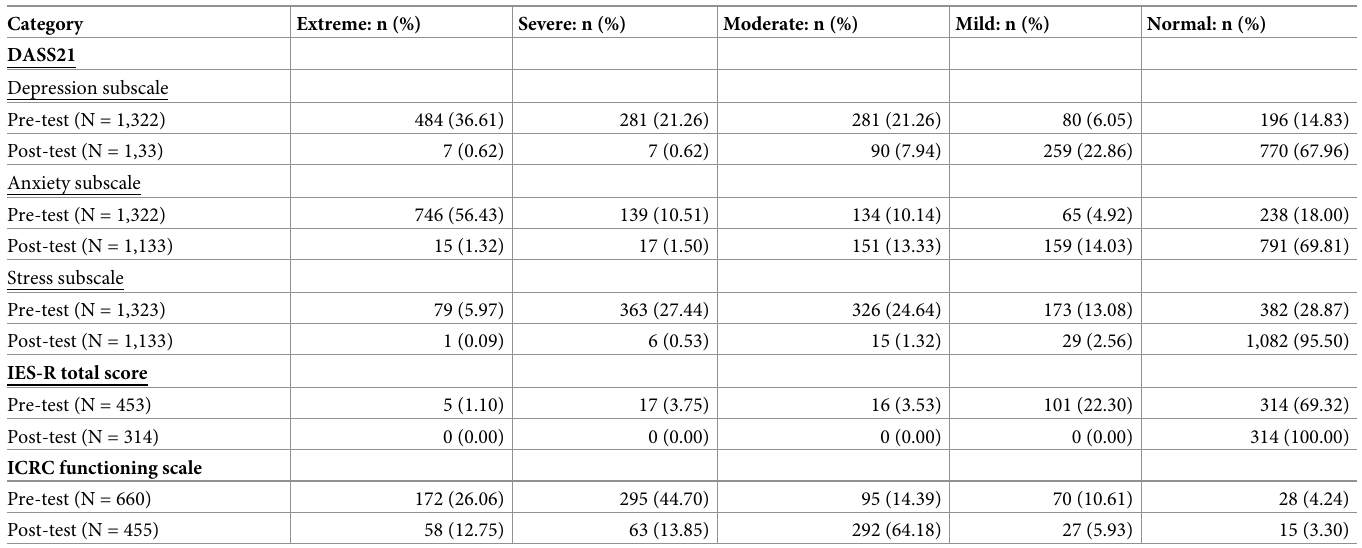
Table 2. Distress and functioning